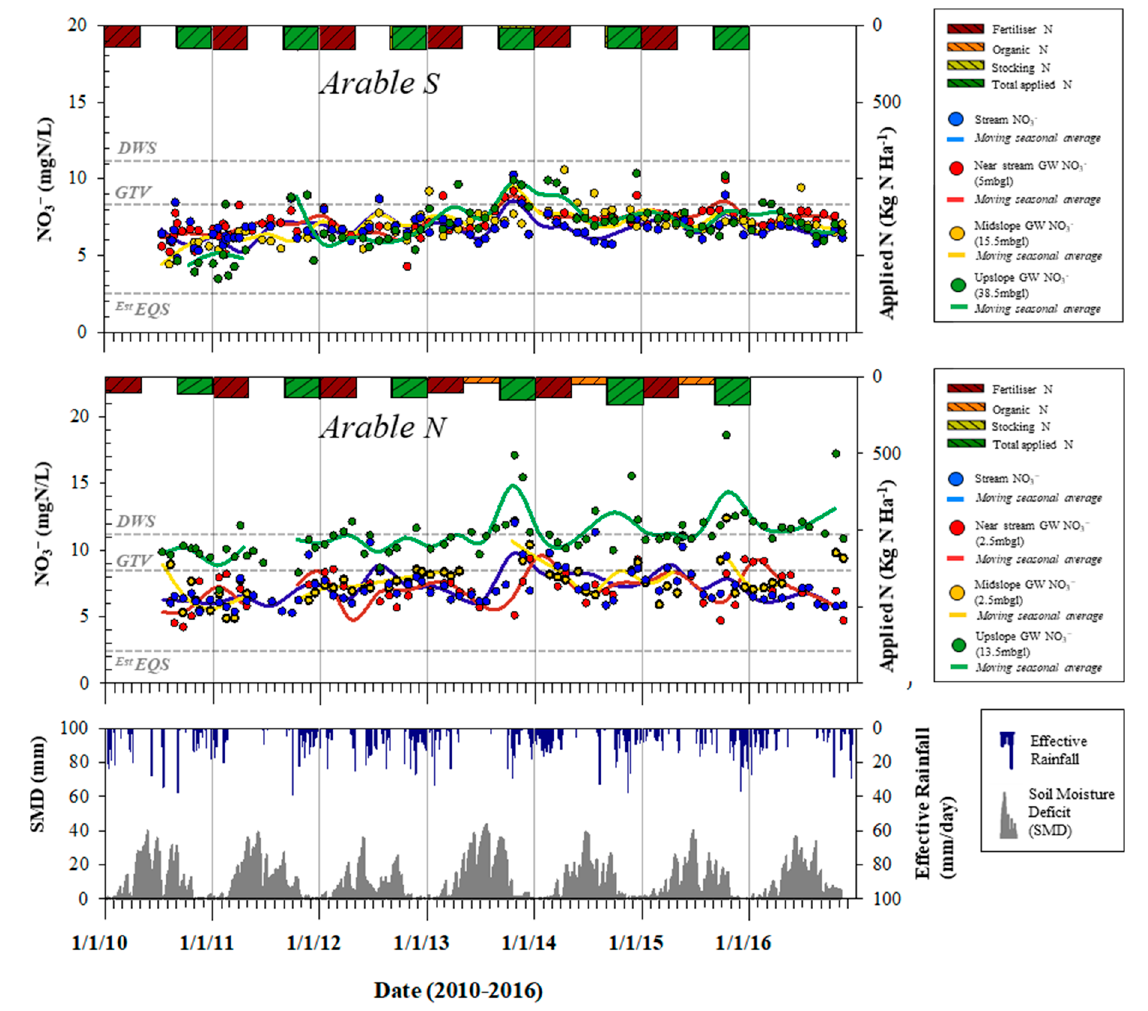
Figure 5. Arable hillslope temporal trends in groundwater and stream NO 3 − , effective rainfall, soil moisture deficit and nitrogen application from 2010 to 2016.